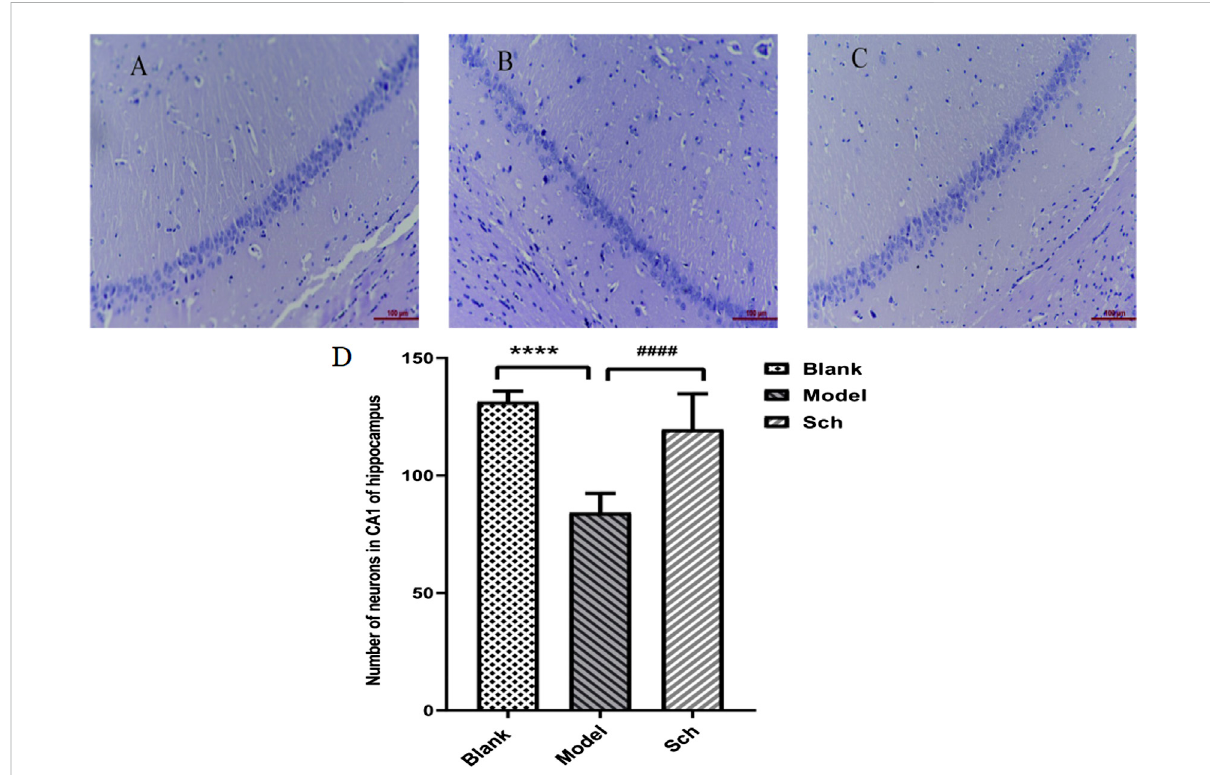
FIGURE 2 H&E staining. CA1 pyramidal cell layer in the hippocampus: (A) blank group; (B) model group; (C) Sch group; and (D) number of neurons in the hippocampus (**** p ≤ 0.0001 vs. blank group; #### p ≤ 0.0001 vs. model group). All results are expressed as the mean ± SD ( n =